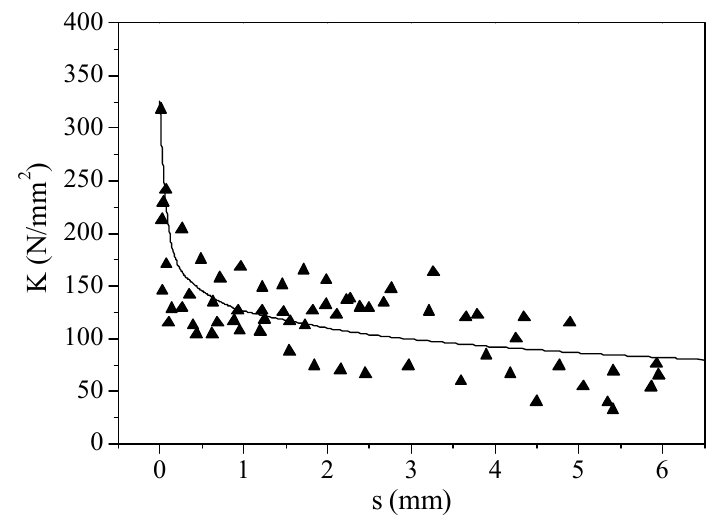
Figure 12. Relationship between unloading stiffness and slip.